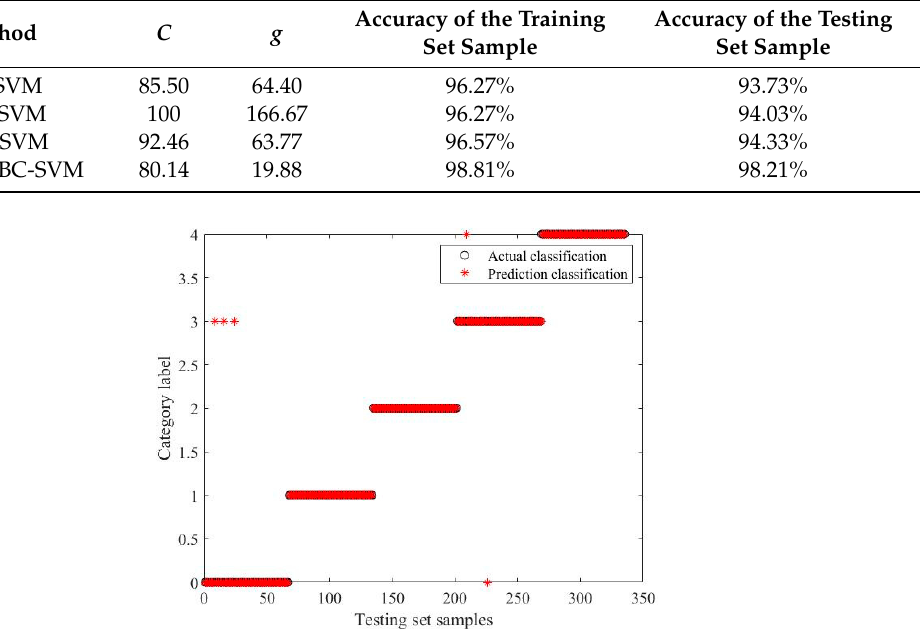
Figure 14. The classification results of the PFCM-ABC-SVM method when the Gaussian noise variance is 0.2.